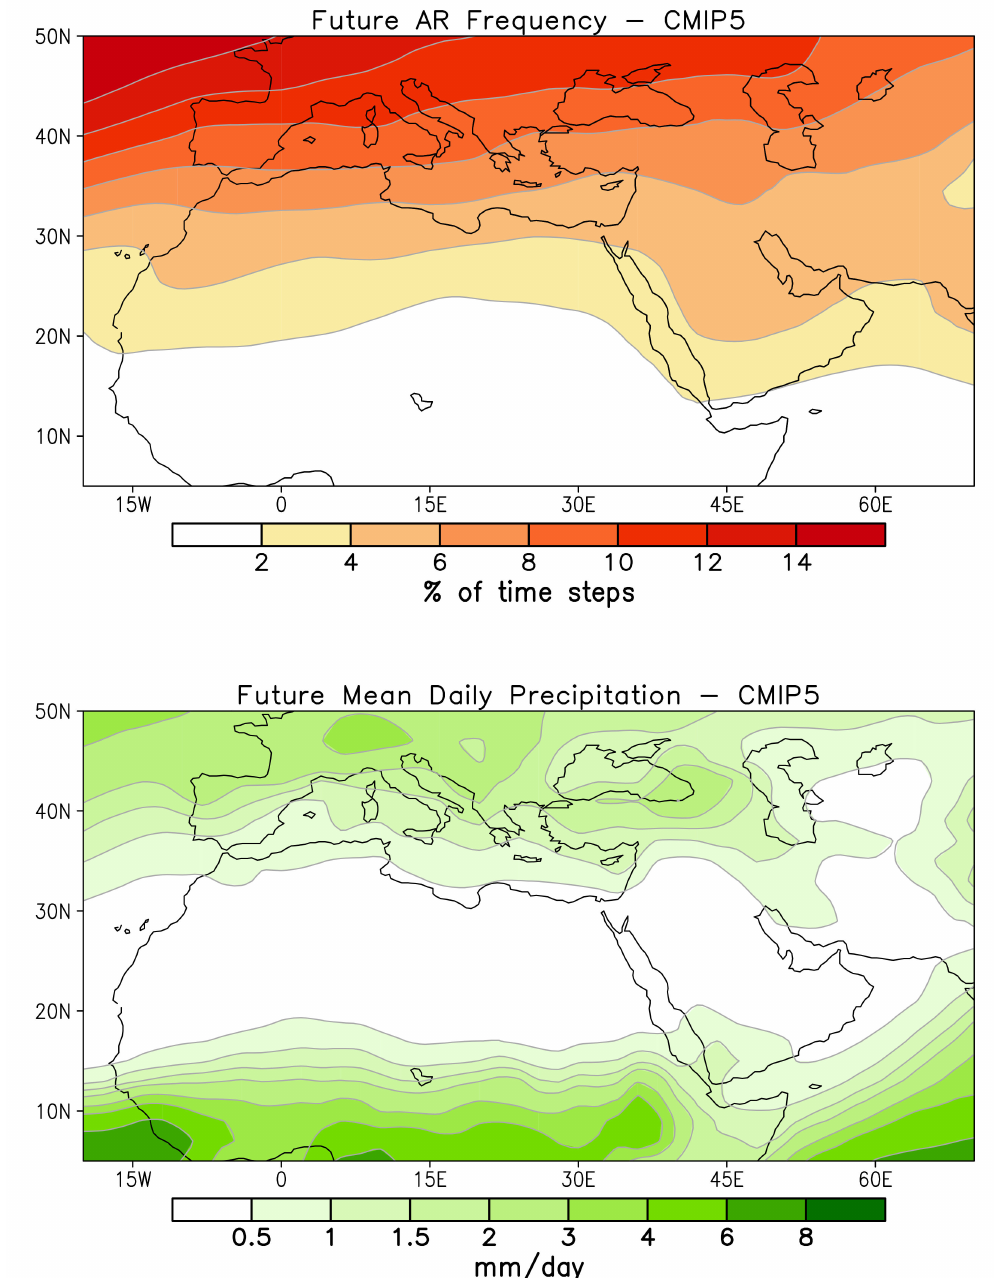
Figure 7. ( Top ) Projected future AR frequency (% of timesteps) for the MENA region obtained from CMIP5 models (RCP85). This figure represents the same process as the AR frequency shown in Figure 6 ( top ), but for the future simulations. ( Bottom ) Projected future mean daily precipitation (mm / day) for the MENA region obtained from CMIP5 models (RCP85). This figure represents the same process as the mean daily precipitation shown in Figure 6 (bottom), but for the future simulations. The CMIP5 future (RCP8.5) scenario simulations range from